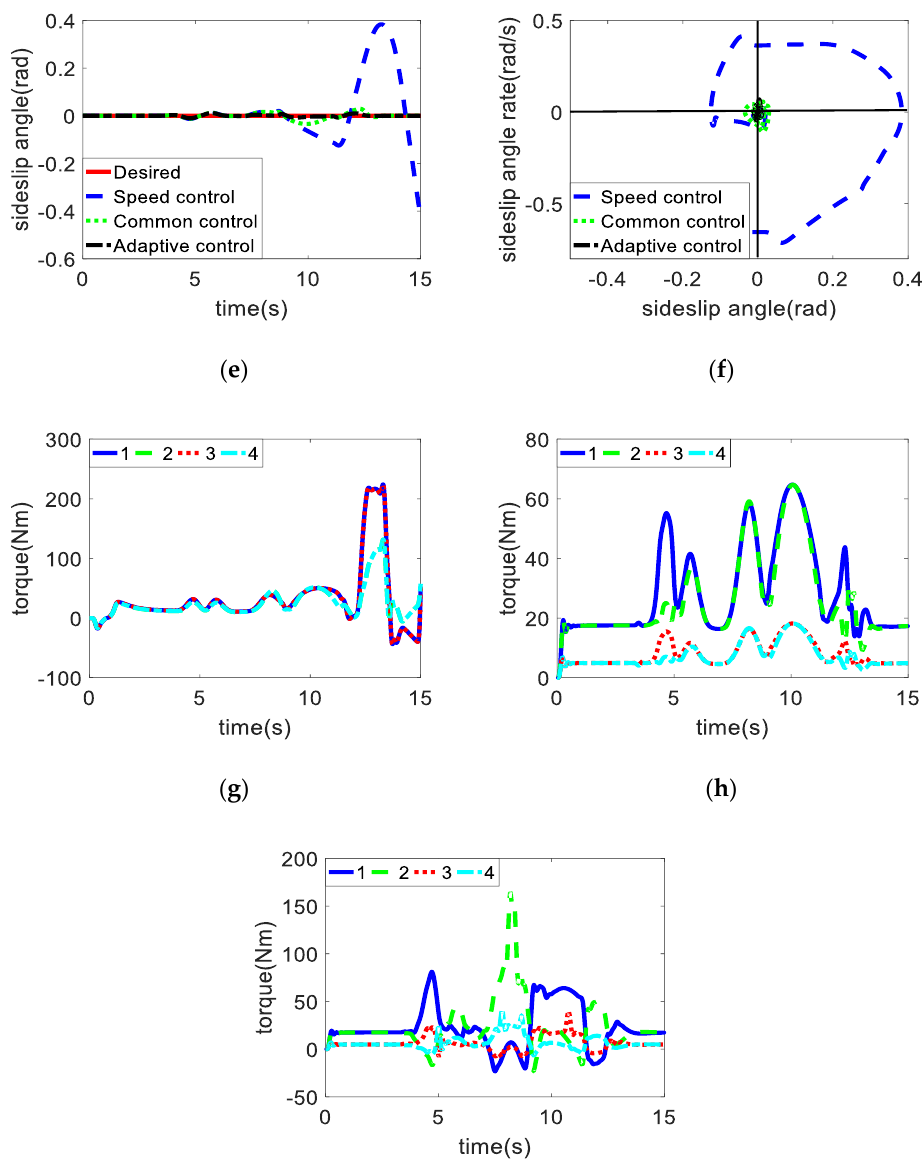
Figure 9. Simulation results for DLC on joint road ( μ = 0.75–0.2). ( a ) adhesion coefficient. ( b ) track. ( c ) speed. ( d ) yaw rate. ( e ) sideslip angle. ( f ) phase plane. ( g ) torque under the speed control. ( h ) torque under the common control. ( i ) torque under the adaptive control.